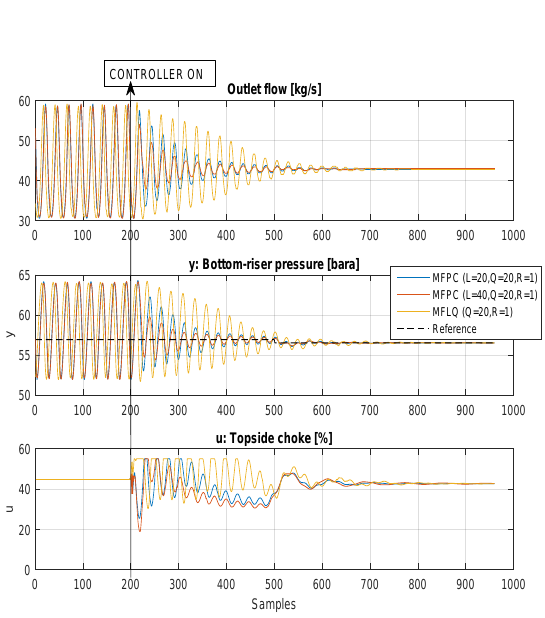
Figure 18: Comparing MFPC to MFLQR using the samples from 1 to 960 in Fig. 17.